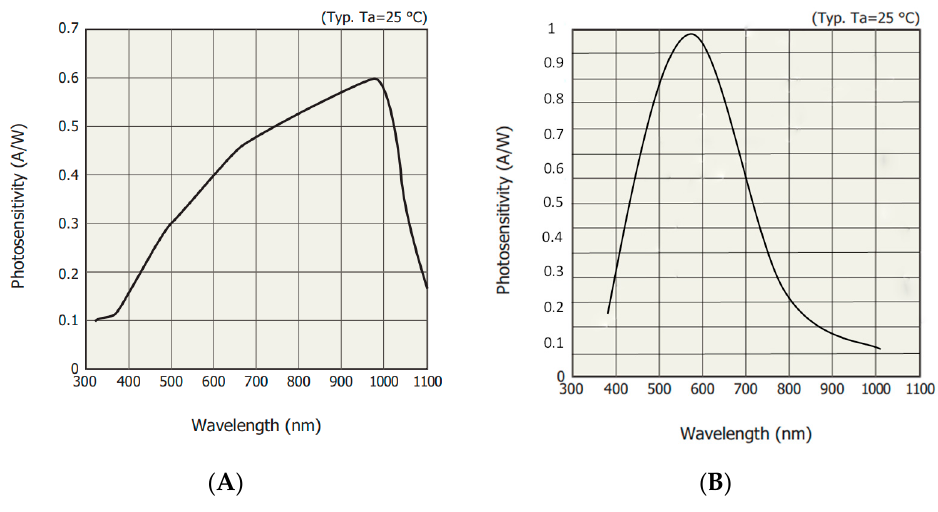
Figure 1. Sensitivity curves of the photodiodes ( A ) S1223 and ( B ) OSD15-E.